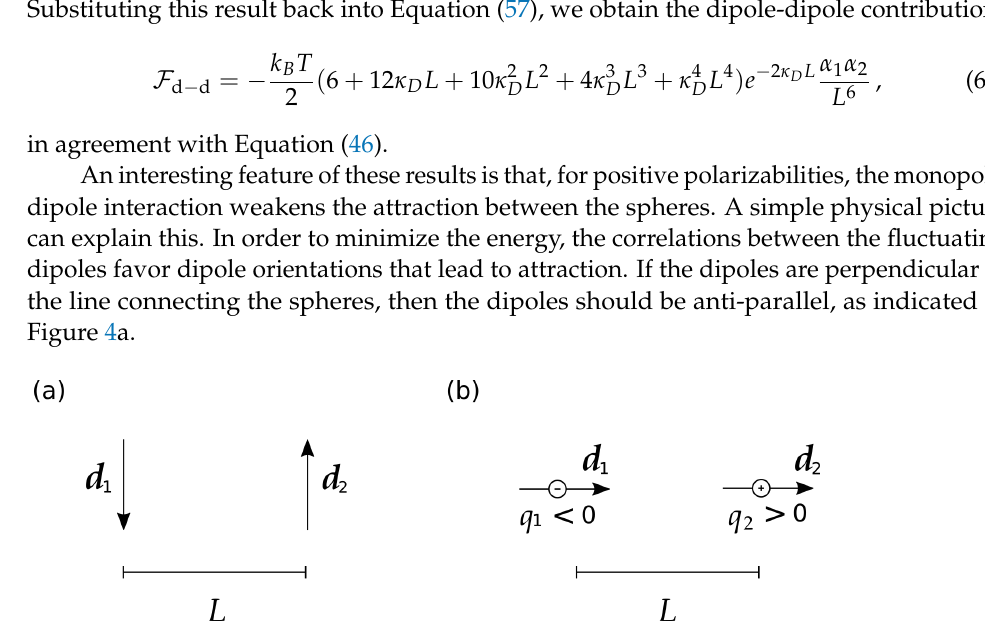
Figure 4. Attractive electrostatic interaction between two fluctuating dipoles in an electrolyte solution for two configurations: ( a ) Dipoles perpendicular to the line connecting them and ( b ) Dipoles parallel to the line connecting them. In situation ( a ), the electrostatic potential generated by each dipole does not induce a charge, while, in situation ( b ), it does, with the signs indicated in the